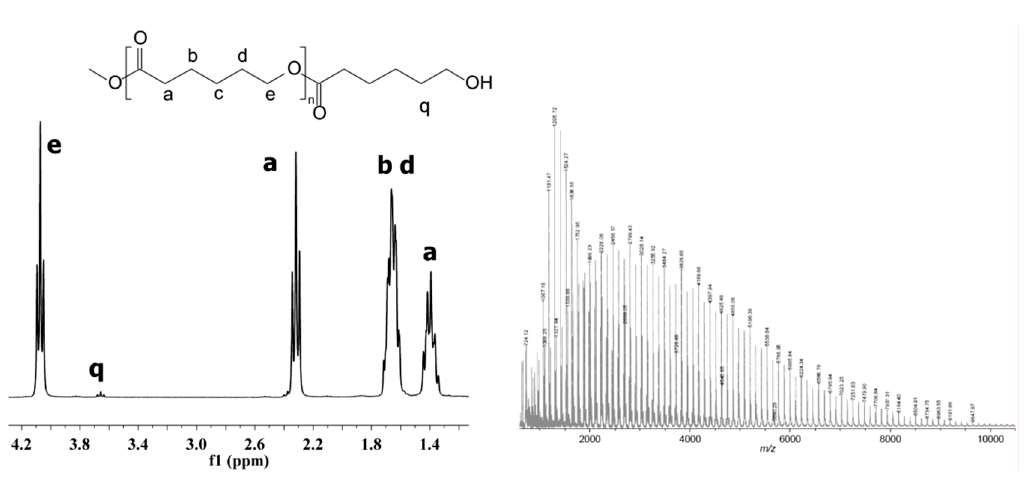
Figure 1. 1 H NMR and MALDI-ToF mass spectrum of synthesized PCL-1 analyzed in CDCl 3 . The reaction was carried out using CALB and [bmim][NTf 2 ] as solvent at 80 °C for 7 days.